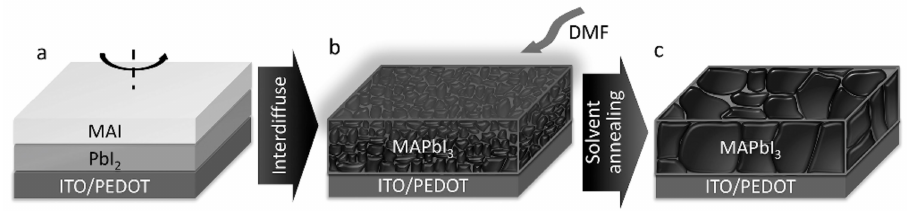
Figure 11. Schematics of the inter-diffusion approach and solvent vapor annealing to increase grain size. ( a ) The deposed PbI 2 and MAI two layers by spin-coating. ( b ) Solvent vapor annealing using DMF vapor. ( c ) The formed high quality film with large grains. Reproduced with permission from Ref.